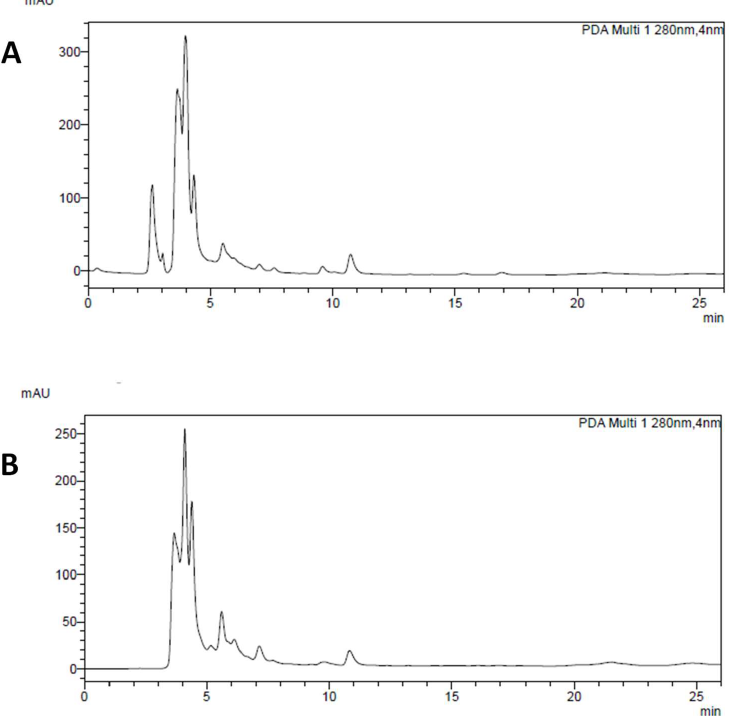
Figure 1. Chromatogram of Cannellino ( A ) and Piattellino ( B ) CW. Gallic acid (RT = 4.5 min) is the main phenolic acid, whereas chlorogenic acid (RT = 10.8 min) is the most present hydroxycinnamic derivative. At RT = 5.5, it is present another phenolic acid, while at RT = 6.2, 7.1, 9.9, 15.5 and 17.1 min, other hydroxycinnamic derivatives are present but not identifiable through HPLC-DAD. The predominant compound in chromatograms of beans after simulated digestion was not present in pre-digested beans; the close RT compared to intact chlorogenic acid (RT = 10.4 vs. 10.8) and a very similar UV spectrum suggested that this compound could be identified as a chlorogenic acid derivative. Other HCD found after the simulated di- gestion (RT = 9.2, 15.3, and 16.8 min), may most likely be derivatives of HCD already found in beans analyzed before the digestive process.